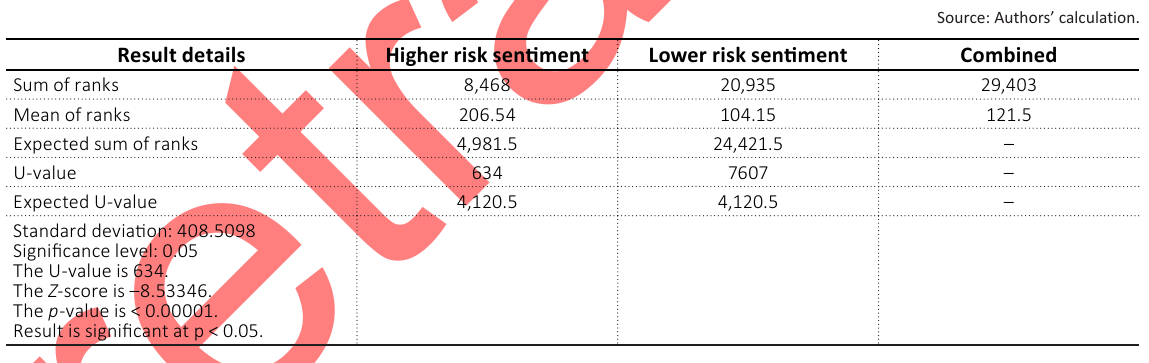
Source: Authors’ calculation.